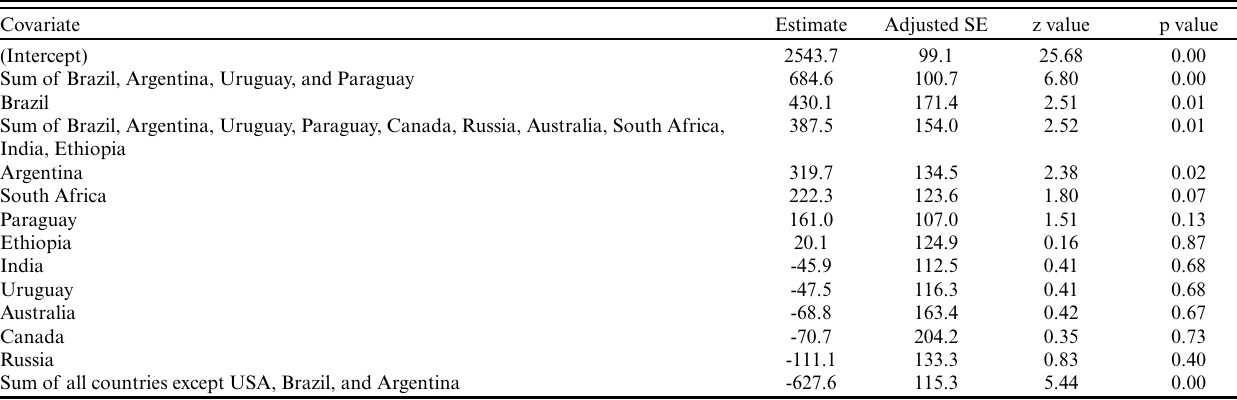
Table 3 . Model averaged regression coefficients and associated statistics derived from the model set in the model selection exercise to assess spillover in the soybean metacoupled system. Covariate indicates covariates from models; Estimate indicates the model averaged regression coefficients; Adjusted SE is the adjusted standard error (Burnham and Anderson 2002); z value is the test statistic for the test; and p value is the p value associated with the test